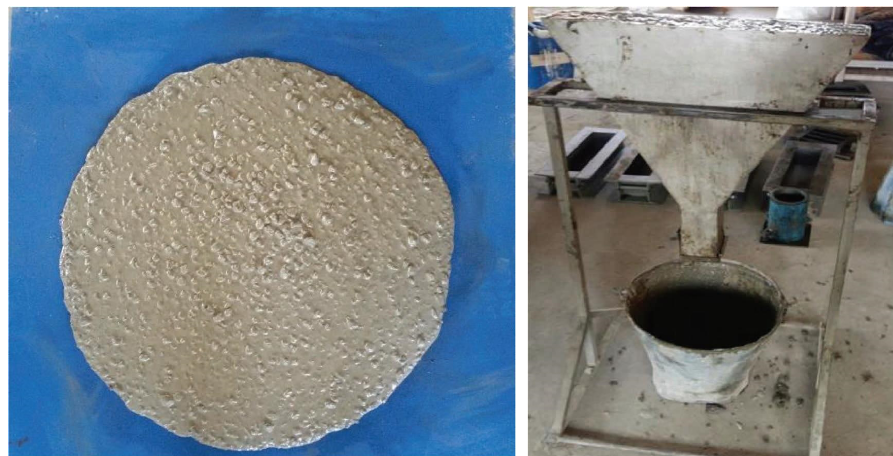
Figure 2: Standard slump cone test and V-funnel test.